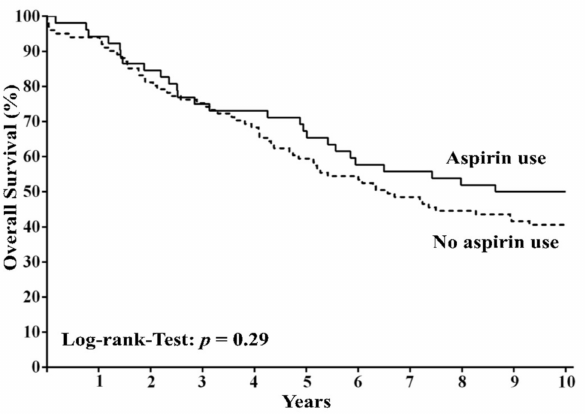
Figure 2. Overall survival among patients with colorectal cancer according to regular use or nonuse of aspirin after diagnosis. The panel shows overall survival among patients with regular use of aspirin and those with nonuse of